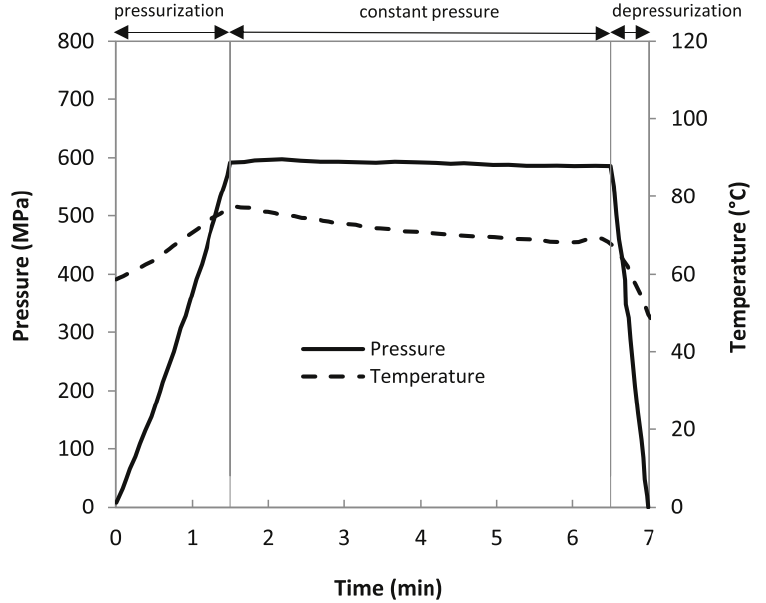
Figure 1. An example of the pressure and temperature (P–T) history of a PATP process (at 600 MPa, 70°C, for 5 min). Adapted with permission [27].